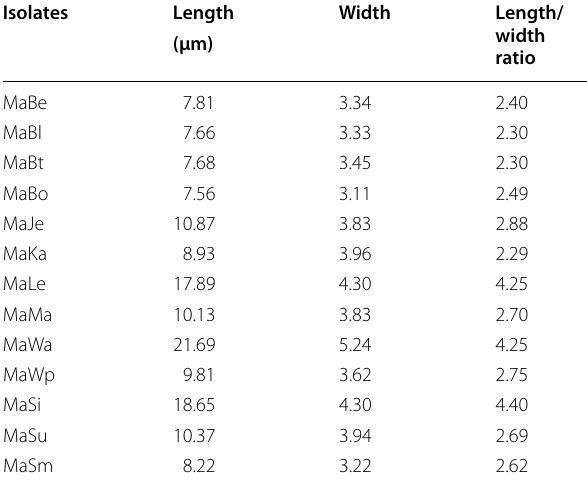
3.83 µm, respectively. The conidial width of isolates var- ied in size from 3.11 to 5.24 µm, resulting in a length/ width ratio in the range of 2.30 to 4.25 µm. Based on the value of length/width ratio of conidia, Metarhizium iso- lates were divided into two groups: the high ratio group with length/width ratio 3.00 µm, were the isolates ≥ MaWa, MaSi, and MaLe, while other isolates included in